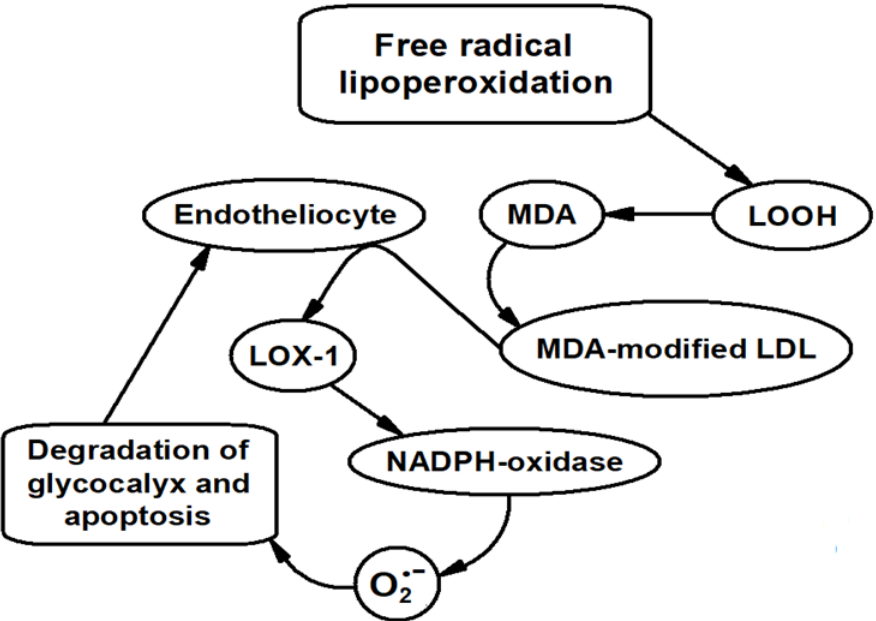
Figure 6. Scheme illustrating the sequence of processes involving MDA leading to endothelial dysfunction.